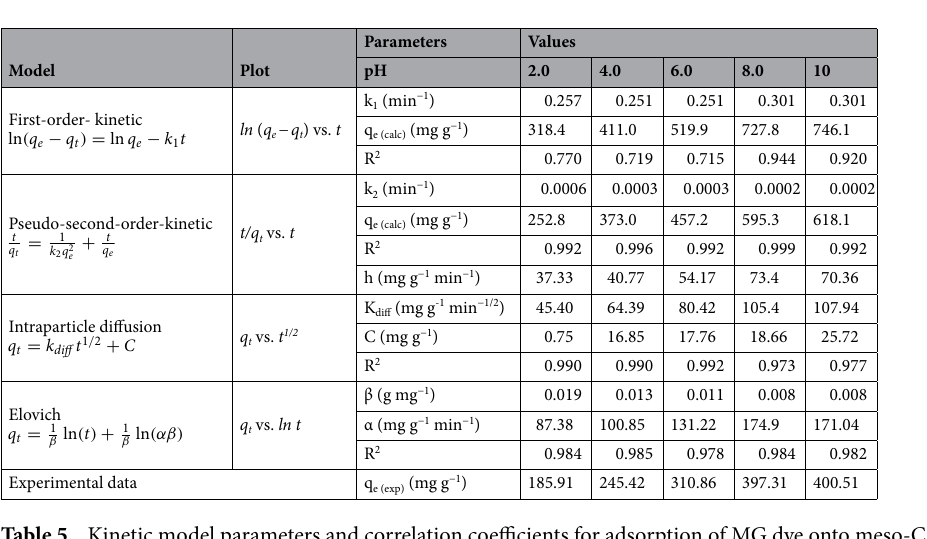
Table 5. Kinetic model parameters and correlation coefficients for adsorption of MG dye onto meso-CaAl 2 O 4 (volume, 50 mL; initial concentration, 50 mg L -1 ; adsorbent dose, 8 mg; solution temperature, 25 ºC).